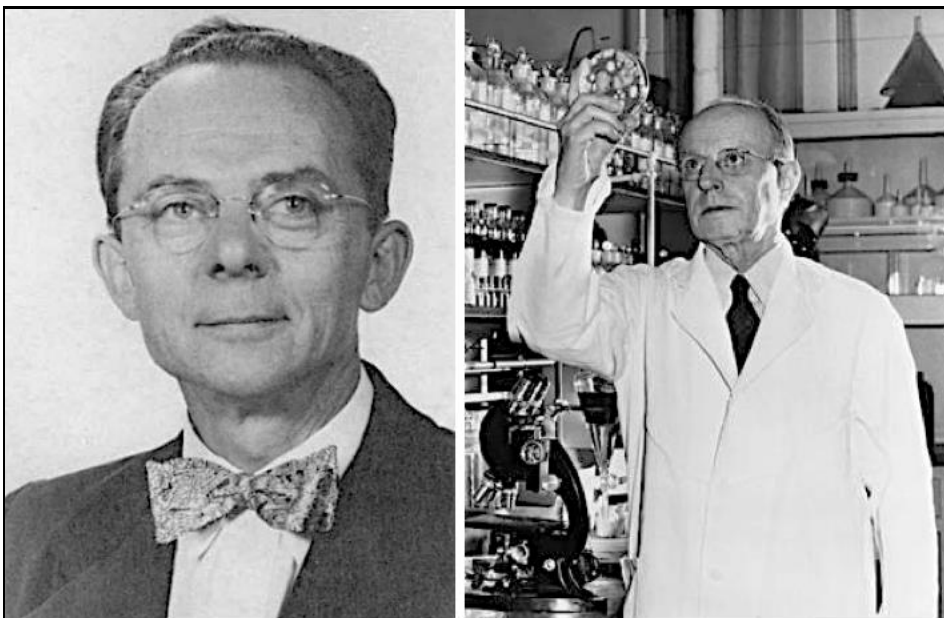
Figure 9. The Bioprospectors. Left. Paul R. Burkholder, the Yale University botanist who discovered chloramphenicol in a soil sample [163,164]. Right. Benjamin Duggar, the botanist at Lederle Laboratories who discovered chlortetracycline in the soil [169].